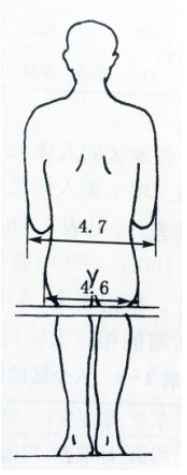
Fig. 2 Horizontal dimension of human